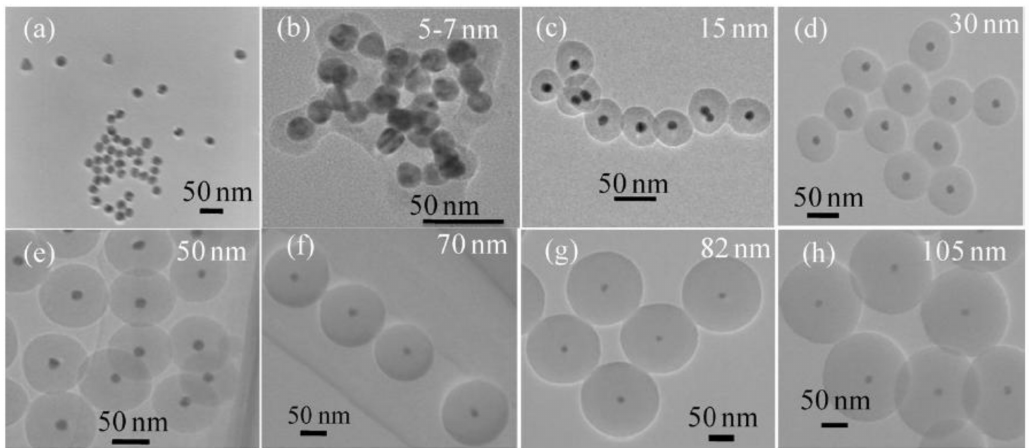
Figure 1. TEM images of silica encapsulated gold nanoparticles. Di ff erent silica shell thicknesses were produced by MAS when concentration of TEOS raised from none ( a ), 1 mM ( b ), 2 mM ( c ), 3 mM ( d ), 5 mM ( e ), 10 mM ( f ), 15 mM ( g ), up to 20 mM ( h ). Reproduced with permission from [84]. Elsevier, 2011.